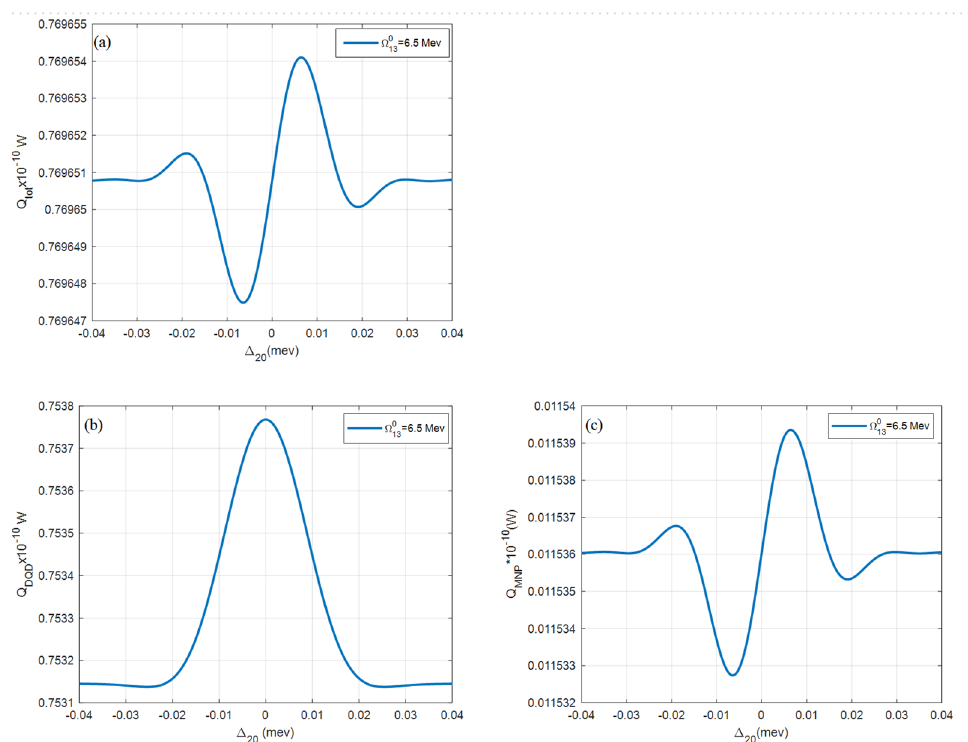
Figure 10. ( a ) The total ( Q tot ) , ( b ) DQD ( Q SQD ), and ( c ) MNP ( Q MNP ) absorption rates from the DQD-MNP hybrid system at R = 20nm and a = 10nm for DQD at a low pumping rate (cid:31) 0 13 = 6.5MeV . Other parameters are (cid:31) 0 02 = 0.09meV , T 01 = 30 γ 0 , T 32 = 8 γ 0